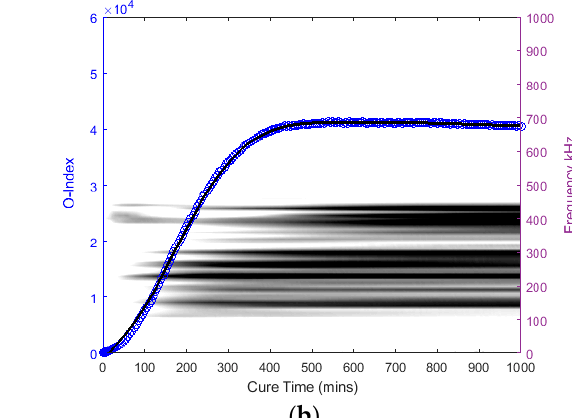
Figure 16. Triangular specimen (Near): O-Index with ( a ) its time derivative and ( b ) its change in frequenc y.